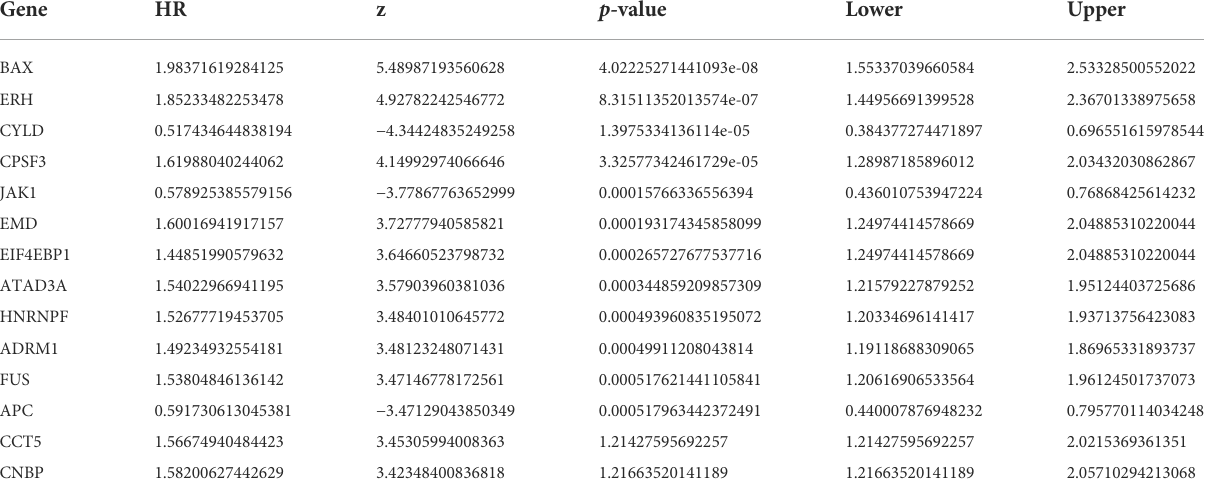
(Figure 1A). Enriched KEGG pathways included Human papillomavirus infection and Basal cell carcinoma (Figure